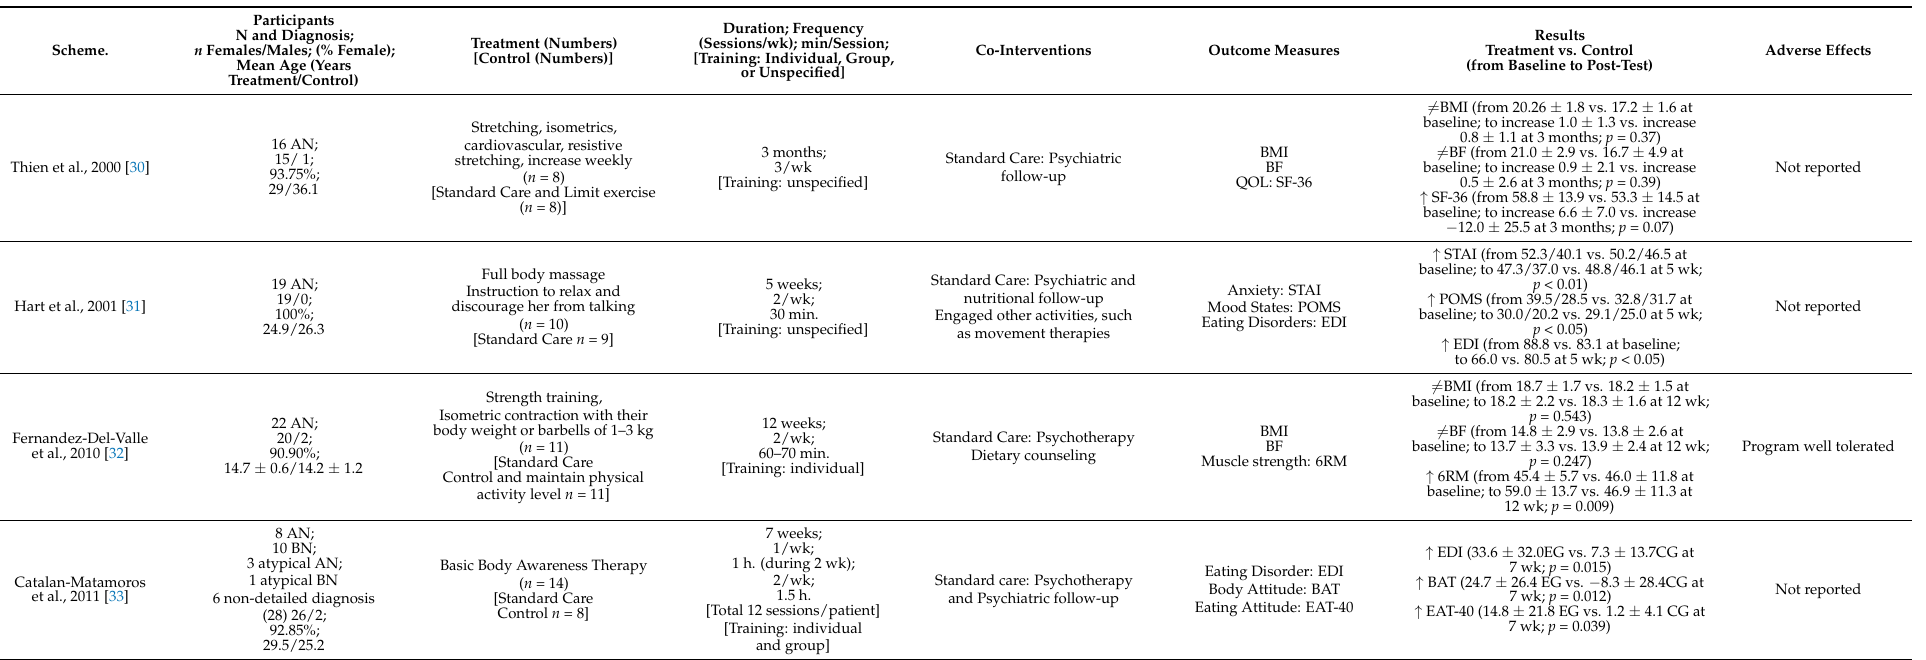
Table 1. Summary of characteristics of included